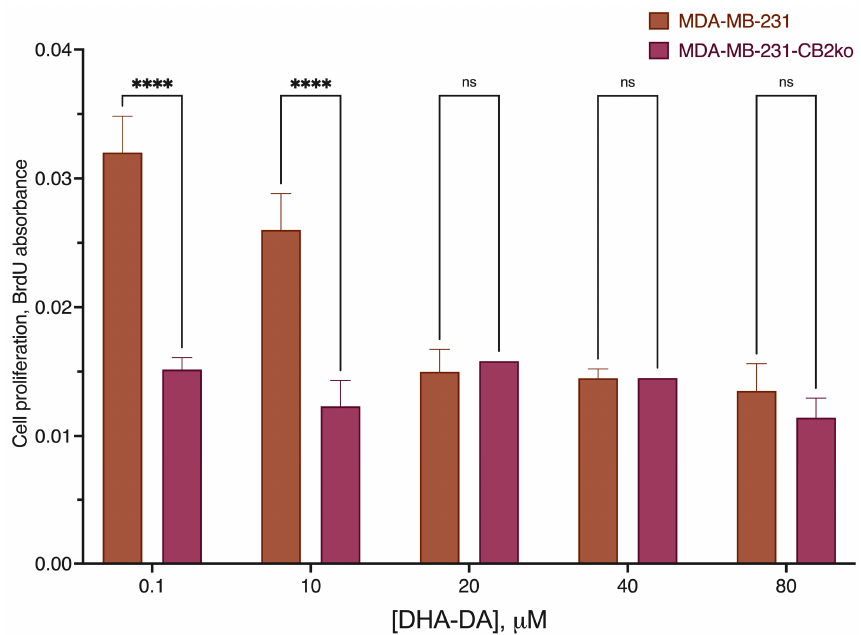
Figure 8. Effect of DHA ‐ DA on the MDA ‐ MB ‐ 231 proliferation after the CB2 receptor knockout. Delipidated serum, 72 h incubation time, BrdU proliferation kit data; ****, a statistically significant difference from the same concentration of the substance on the original cell line in the ANOVA test with the Holm–Sidak post ‐ test; ns, not significant.